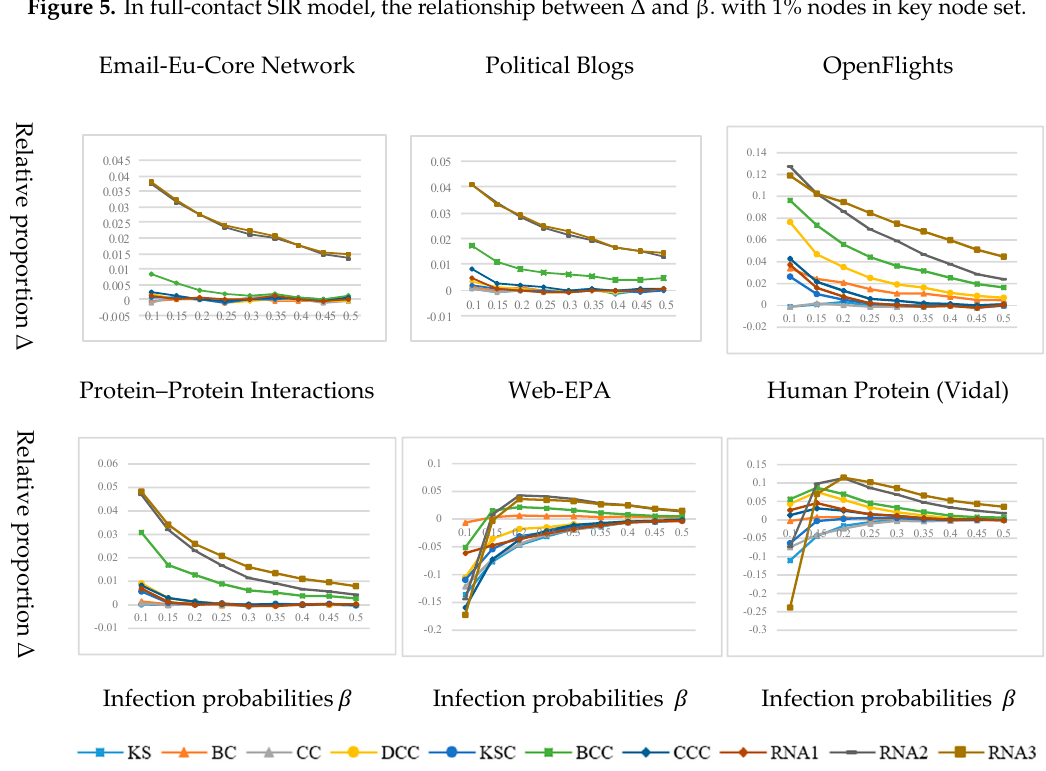
Figure 6. In full-contact SIR model, the relationship between Δ and β . with 3% nodes in key node- set.